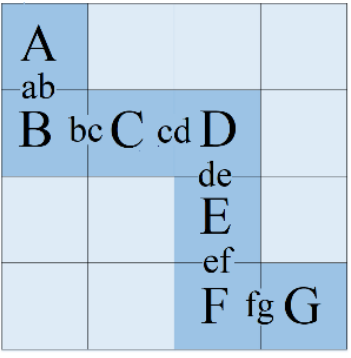
Figure 2. Selecting specific faces.